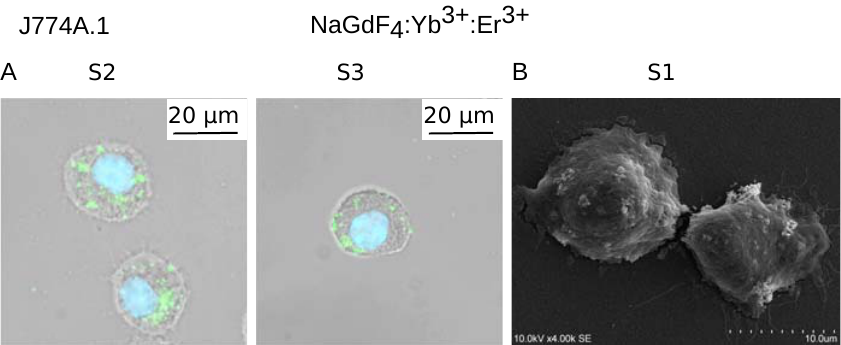
Figure 4. ( A ) Bright field microscopy combined with fluorescence microscopy ( λ ex = 975 nm; λ em = 945 nm) showing interactions of S2 and S3 NaGdF 4 NPs (5 µ g/mL) with J774A.1 cells after a 1-h treatment; ( B ) SEM image of S1 NaGdF 4 NPs.